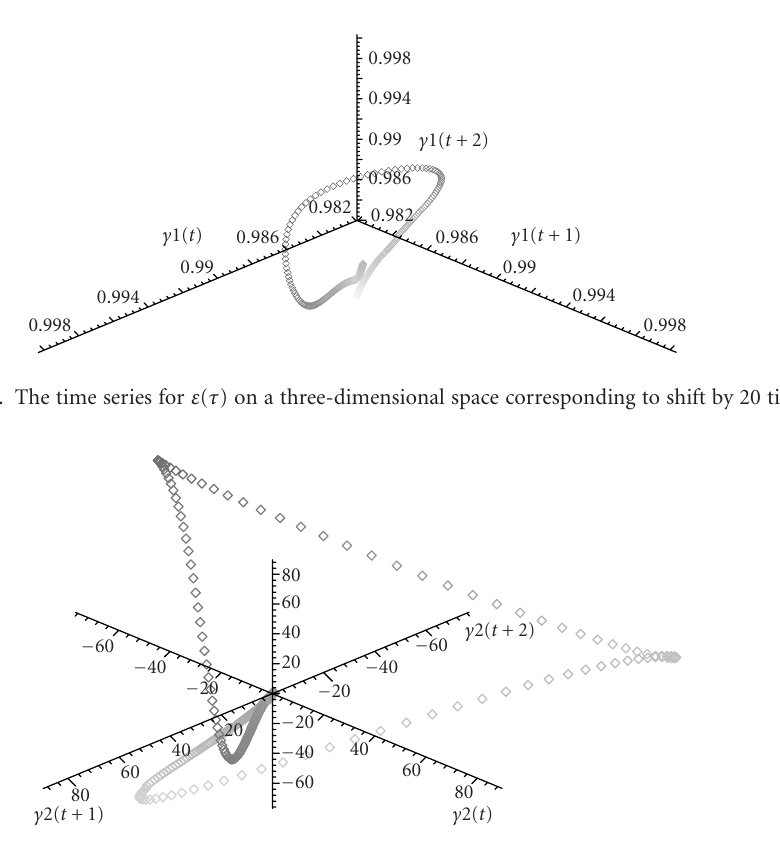
Figure 5.10. The time series for ˙ ε ( τ ) on a three-dimensional space corresponding to shift by 40 time steps.